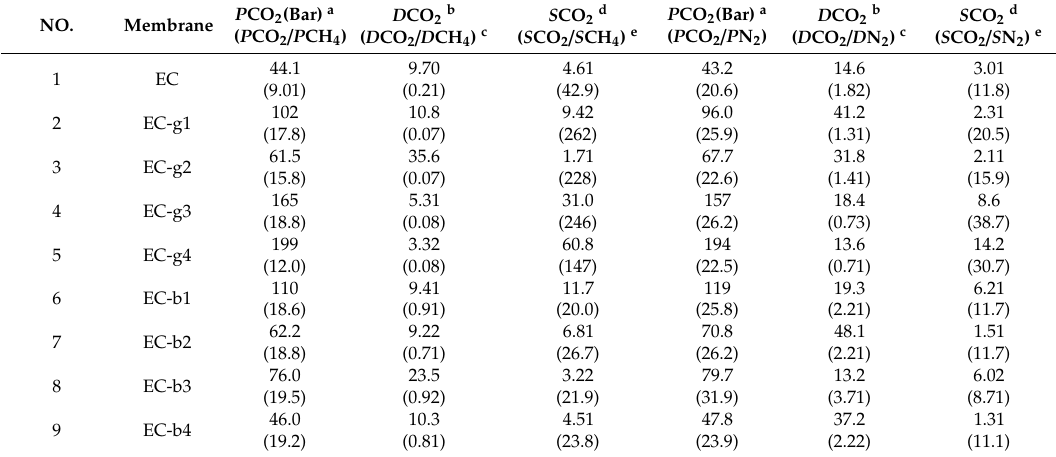
Table 2. Gas permeation properties of EC membranes modified with ionic